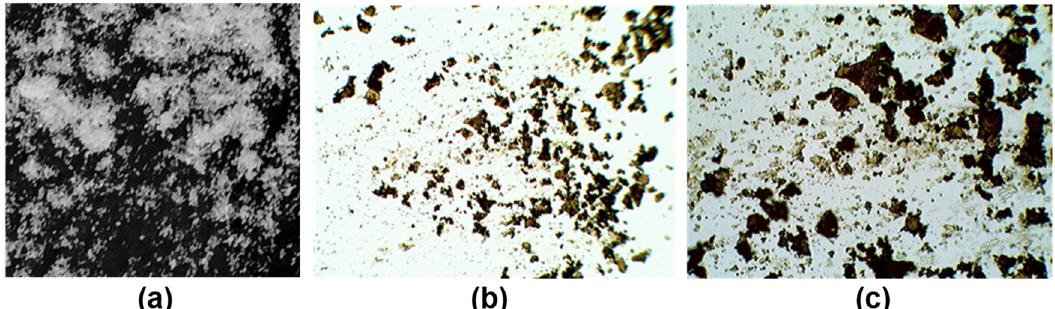
Figure 4: The powder of phosphor sample D after ball milling, washing, drying the water colloid in a Petri dish in the open air and scraping from the bottom of the Petri dish. Oleic acid was added to the colloid before drying. ( a ) The photograph of the scales of the dry powder taken with iPhone 6 camera; dimensions are the same as in Figure 3. ( b ) The microscope photograph of the scales taken with magni fi cation × 40. ( c ) The microscope photograph of the scales taken with magni fi cation × 100; dimensions are the same as in Figure 3.